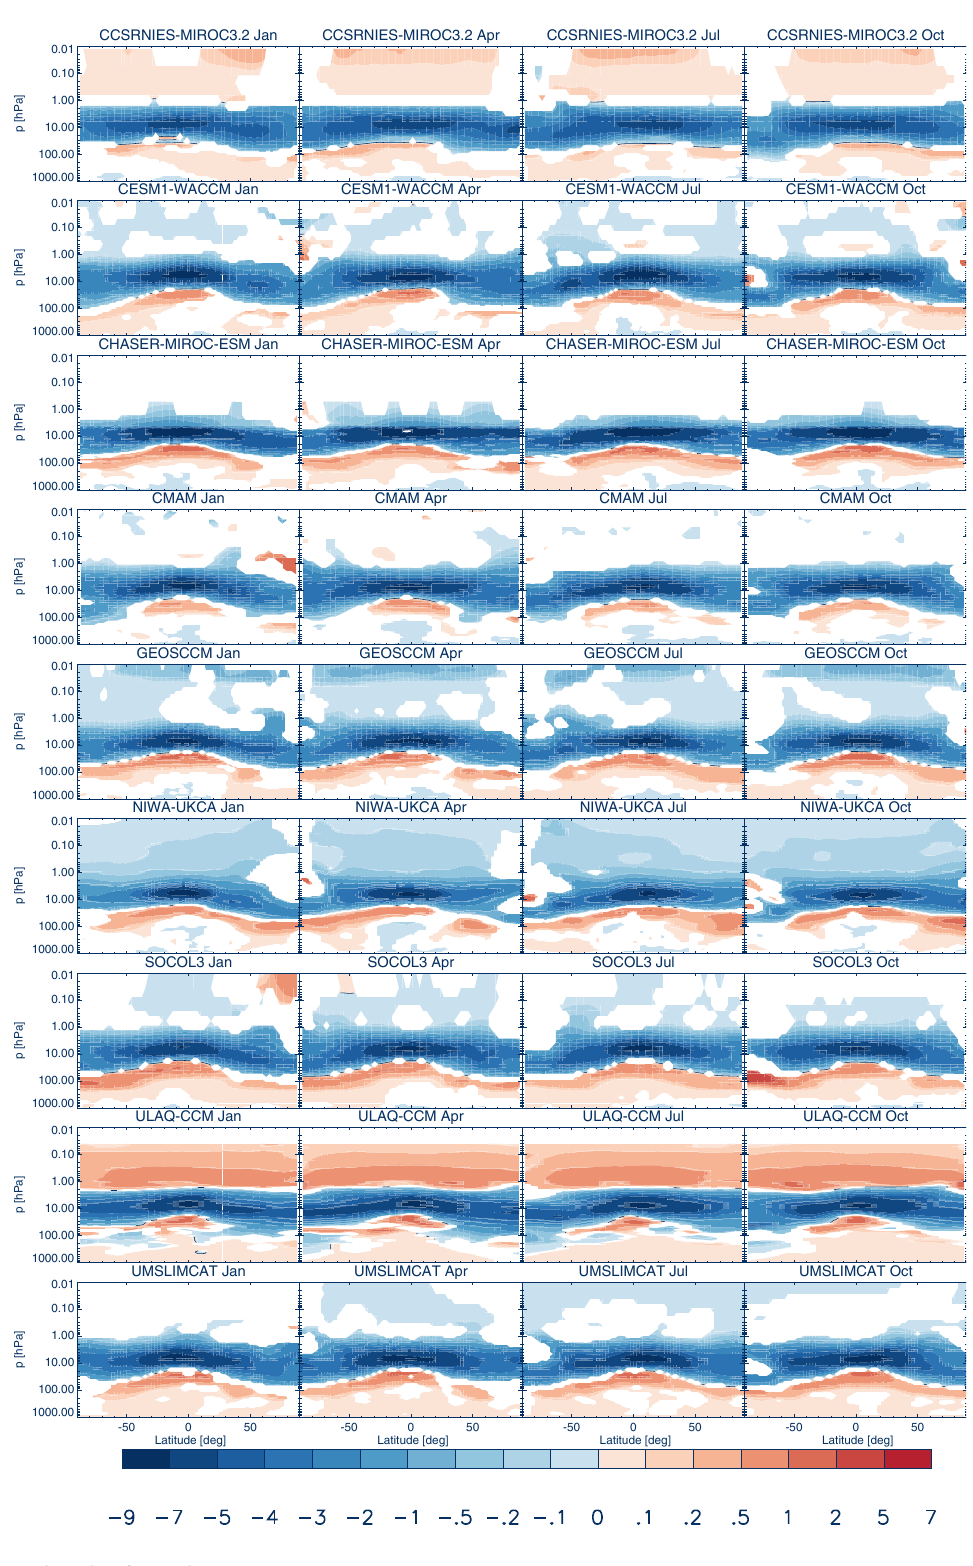
Figure 4. Same as Fig. 1 but for N 2